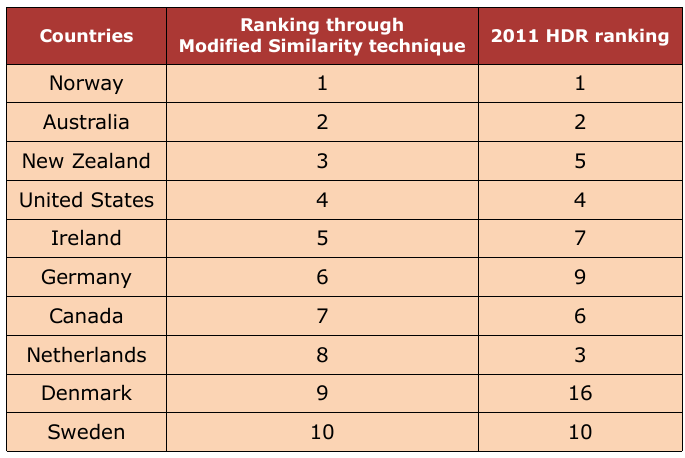
Step9. Ranking the alternatives